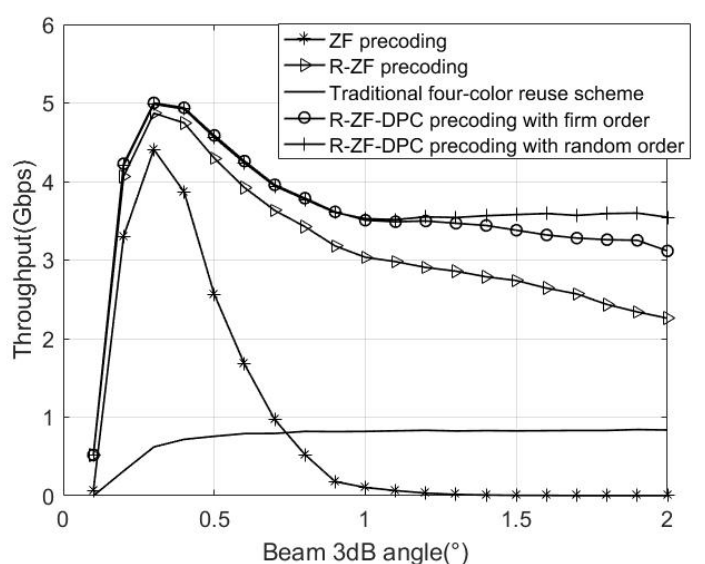
Figure 7. Influence of 3 dB angle on throughput performance of precoding schemes with users distributed at the edge of the